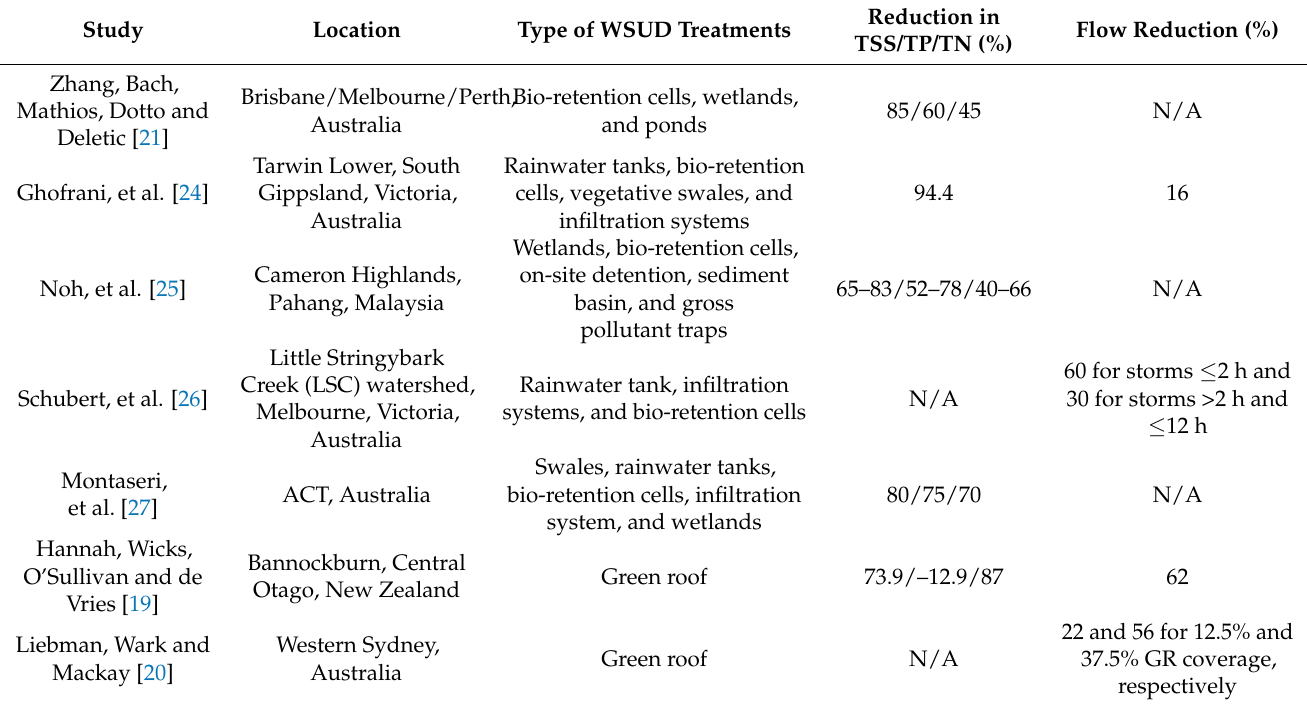
Table 1. A summary of application of MUSIC in recent studies.